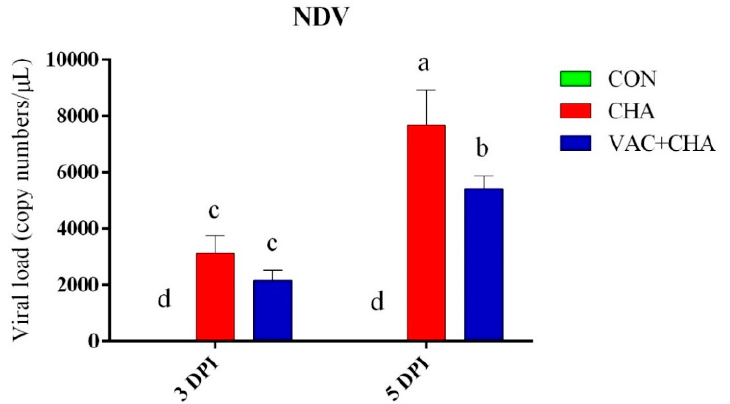
Figure 1. Relative quantity of the NDV-M gene in the pancreas of chicken. The bars represent the standard deviation of the mean. Columns without a common superscript letter differ significantly ( p < 0.05) in the figure. CON, control; CHA, Newcastle disease virus challenged; VAC + CHA, vaccinated with LaSota and challenged with virulent Newcastle diseases virus after 2 weeks of vaccination. The NDV-M gene was not detected in the control group.